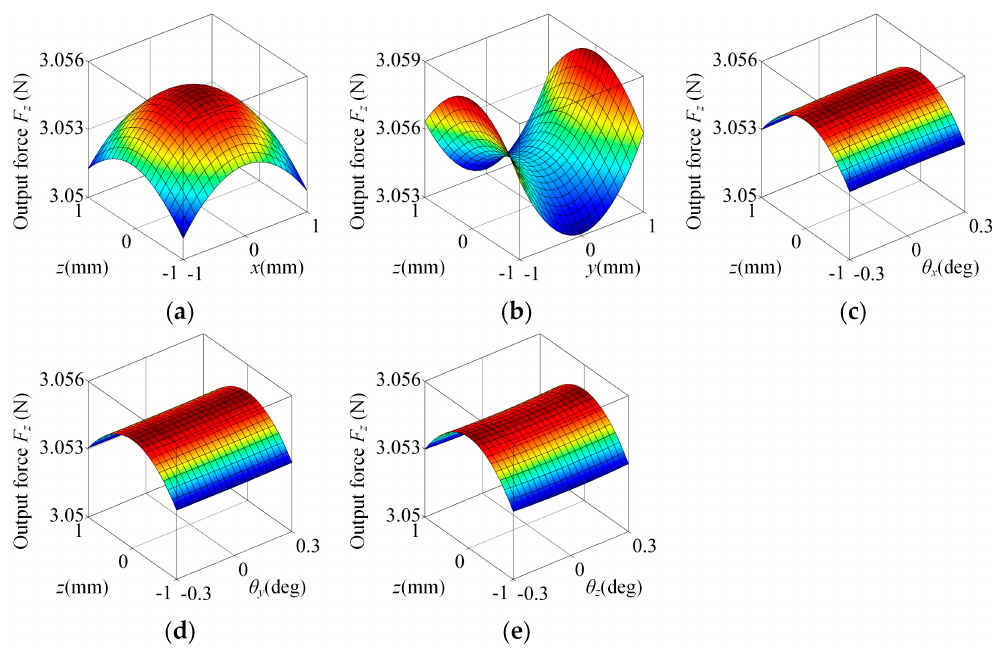
Figure 6. Output force F z characteristic of the HMF-VCA varied with the mover’s motion. ( a ) F z vs. z and x . ( b ) F z vs. z and y . ( c ) F z vs. z and θ x . ( d ) F z vs. z and θ y . ( e ) F z vs. z and θ z